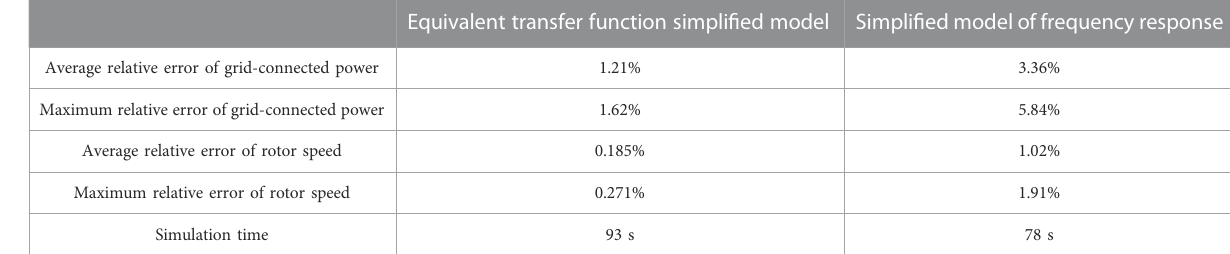
TABLE 2 Error analysis for simpli fi ed models.